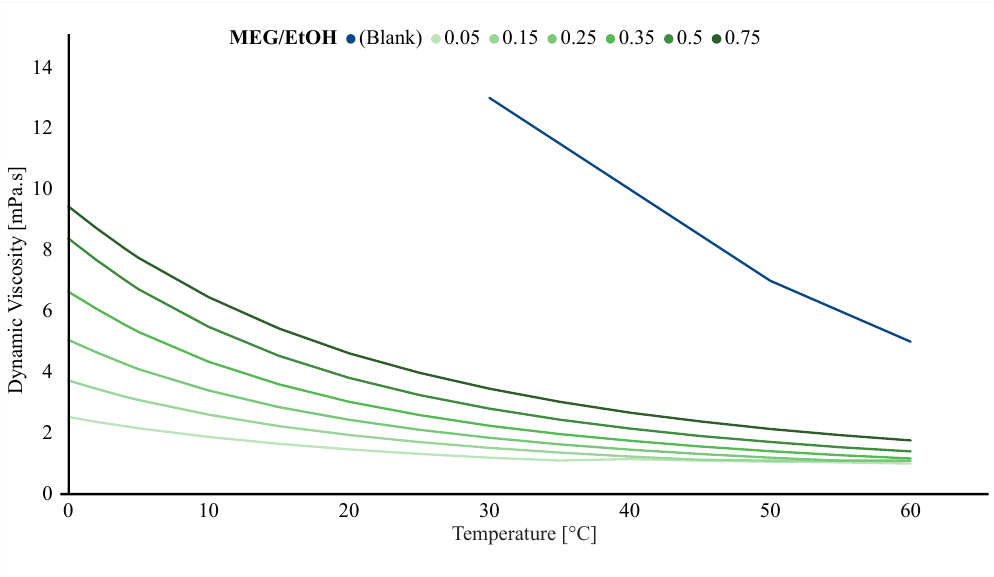
Figure 4. Comparison between the dynamic viscosity of the MEG/EtOH mixture as function of temperature for different %MEG/EtOH using a shear rate of 100 1/s and the dynamic viscosity of a pure MEG solution (Blank).